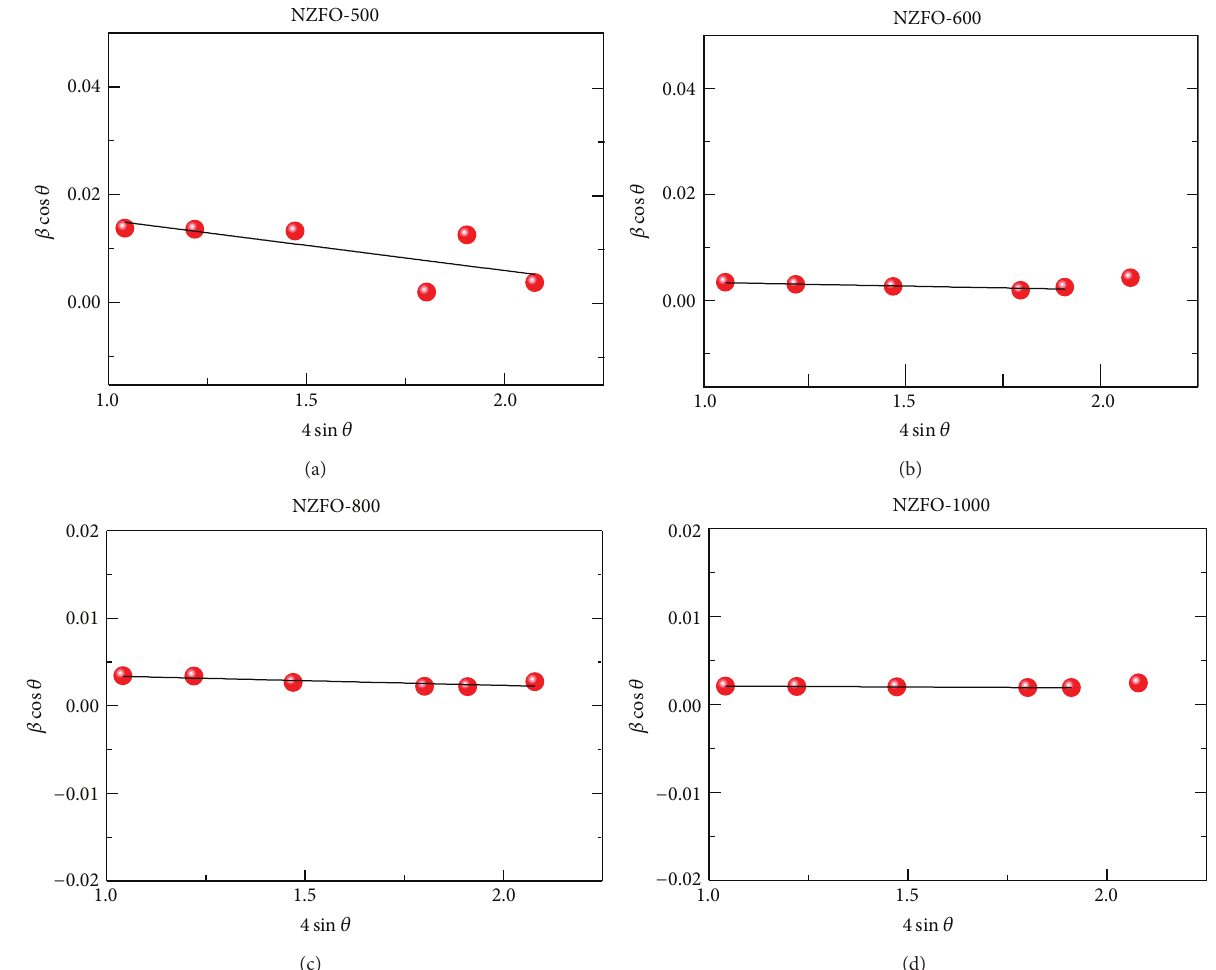
Figure 2: Williamson and Hall plot graphs for NZFO-500, NZFO-600, NZFO-800, and NZFO-1000.